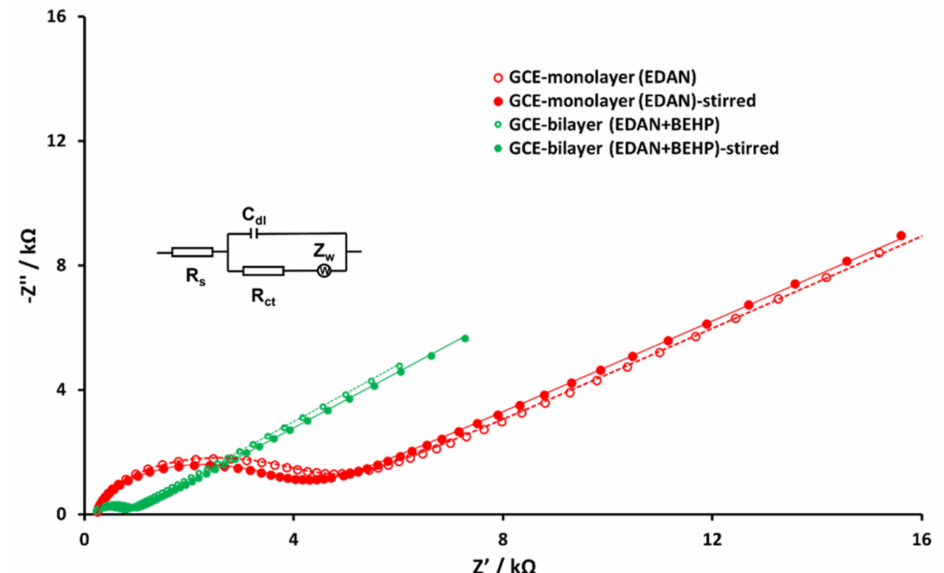
Figure 5. Nyquist plots of modified GCEs with monolayer (the first layer) (GCE-(EDAN); green circles), and bilayer (GCE-(EDAN+BEHP); red circles). Results are shown before (empty circles) and after (filled circles) stirring at 500 rpm for 5 min using [Ru(NH 3 ) 6 ] 3+ as the positively-charged redox probe with the applied frequency ranging from 100 MHz to 100 kHz. The values of each equivalent circuit element are included in Table